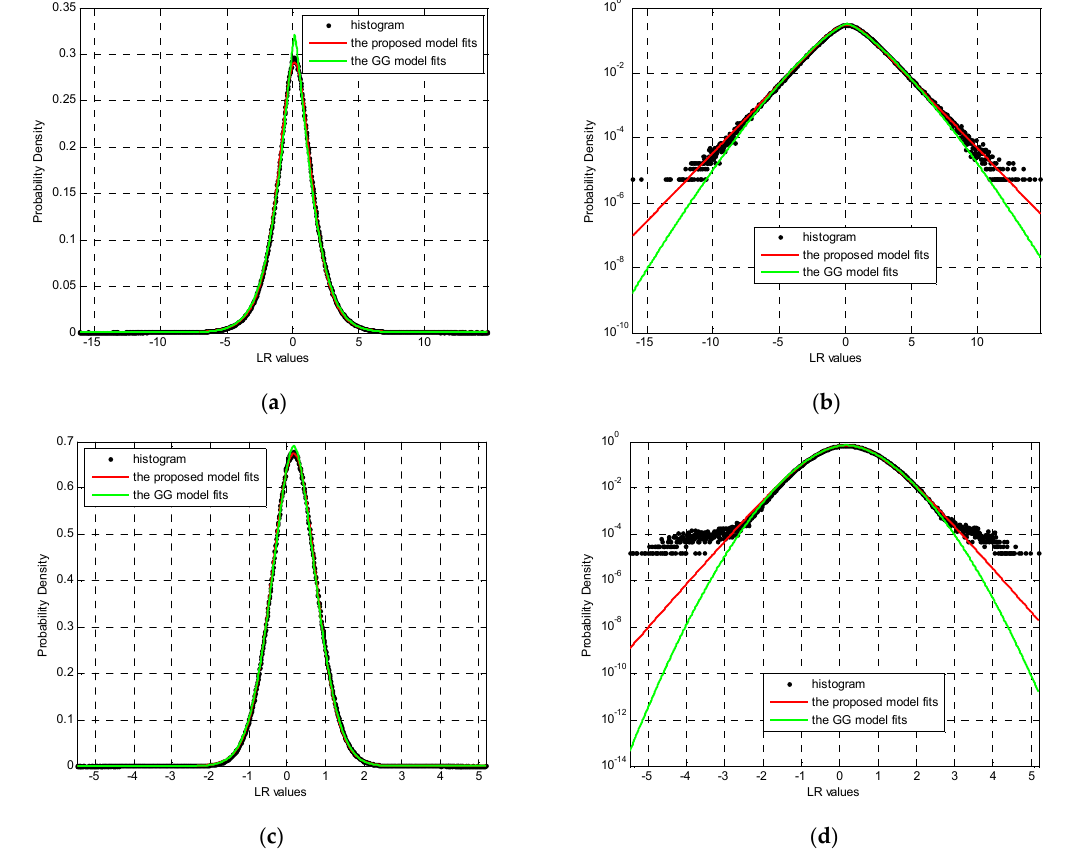
Figure 4. Fitting results of the proposed model for the data shown in Figure 2: ( a ) and ( b ) are the results for a 1 × 1 filtering window displayed on linear and semi-log scales, respectively; ( c ) and ( d ) are the results for a 5 × 5 filtering window displayed on linear and semi-log scales, respectively.